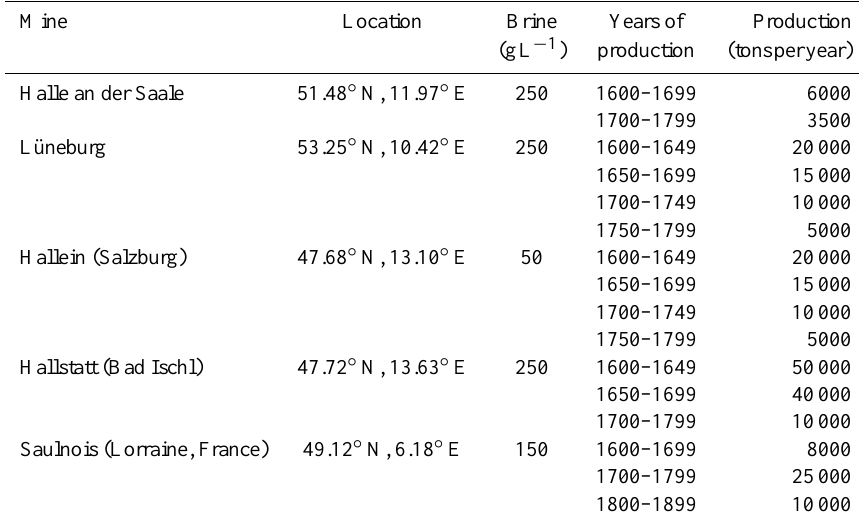
Table 2. Summary of European salt mine characteristics important for wood consumption during 1600–1900. The final two columns are estimates based on information found in Bergier